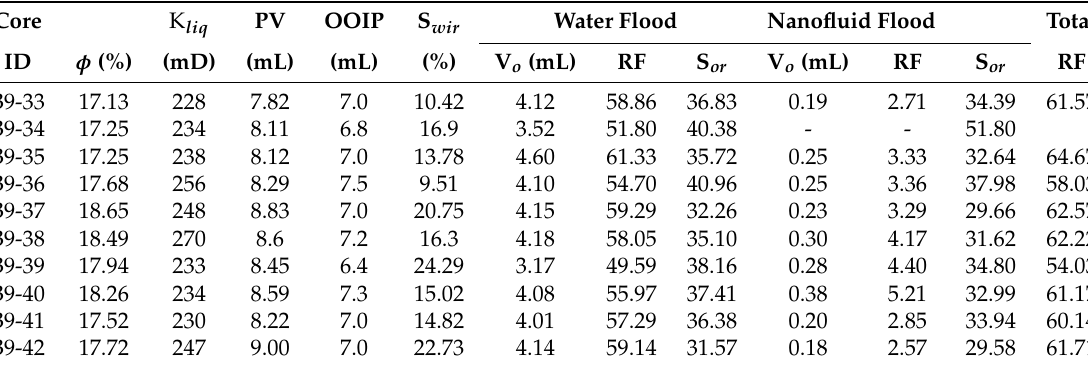
Table A2. Petrophysical properties of neutral-wet cores used for secondary nanofluid flooding experiments. The S wir and OOIP were established by centrifuge. The porosity and permeability were determined by helium porosimeter and gas permeameter, respectively.